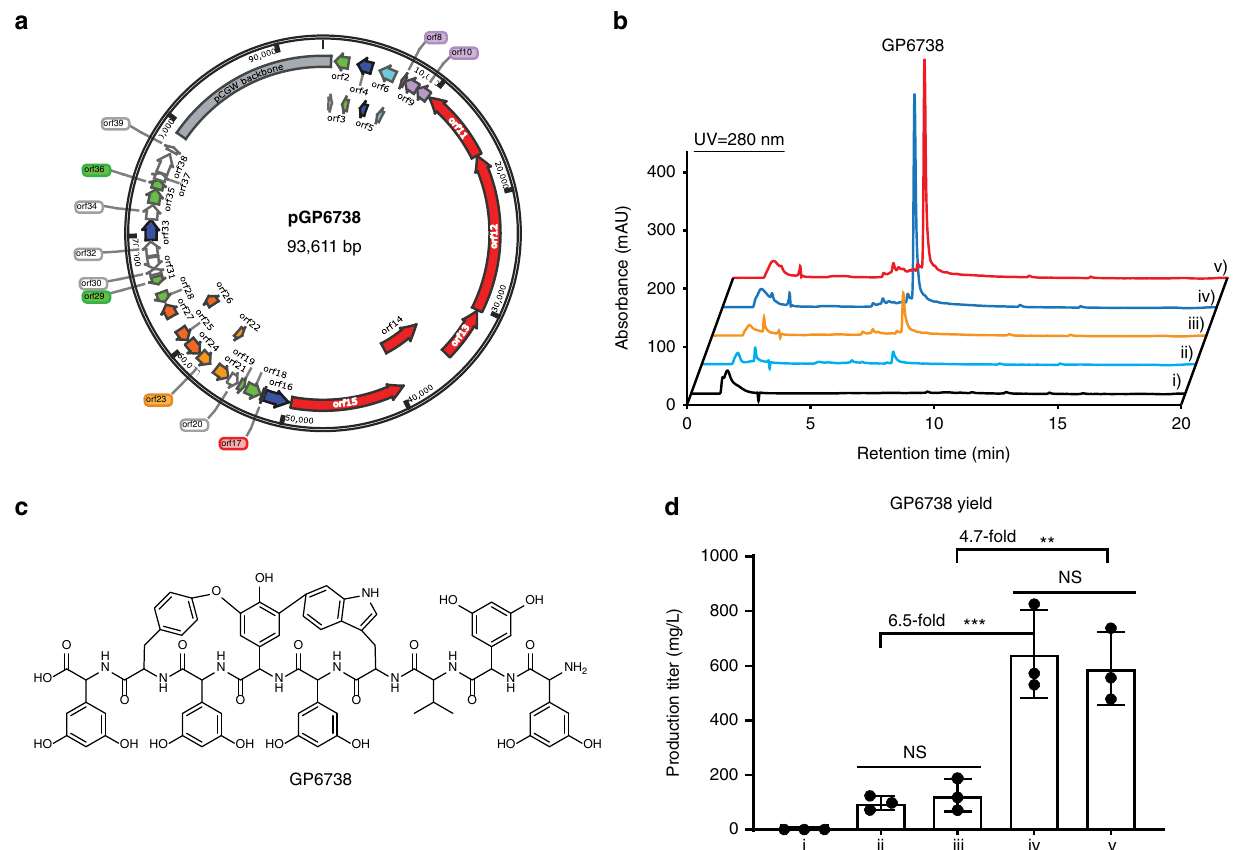
Fig. 4 Discovery of the cryptic GP6738 from S. sp. WAC06738 using GPAHex. a pGP6738 bearing GP6738 BGC captured through TAR. Genes are color- coded as in Figs. 1 and 2. b Heterologous expression of GP6738 using GPAHex. No GP6738 was detected in the parent S . sp. WAC06738 (i)). A prominent GP6738 peak was detected in all heterologous expression strains: S. coelicolor M1154/pGP6738 (ii)), S. coelicolor M1154/pAMX4/pGP6738 (iii)), S. coelicolor M1154/pGP6738/pIJ10257-sl (iv)), and S. coelicolor M1154/pAMX4/pGP6738/pIJ10257-sl (v)). Overexpression of the pathway-situated regulators highly increased GP6738 production. c Chemical structure of GP6738. GP6738 bears a rare nonapeptide scaffold harboring a Val3 residue and the characteristic Tyr-Hpg-Trp dual crosslinks of Type V GPAs. d Quantitation of GP6738 production. Overexpression of strR-lmbU regulators increased the yield of GP6738 by 6.5-fold in S. coelicolor M1154 and 4.7-fold in the GPAHex production chassis. Mean with error bars showing s.d. of three biological replicates ( n = 3) is plotted. Multiple comparison signi fi cance was tested to *** P = 0.0003 or ** P = 0.0005 by one-way ANOVA with Turkey ’ s post hoc analysis. NS, not signi fi cant. Similar results ( d ) were obtained from two independent